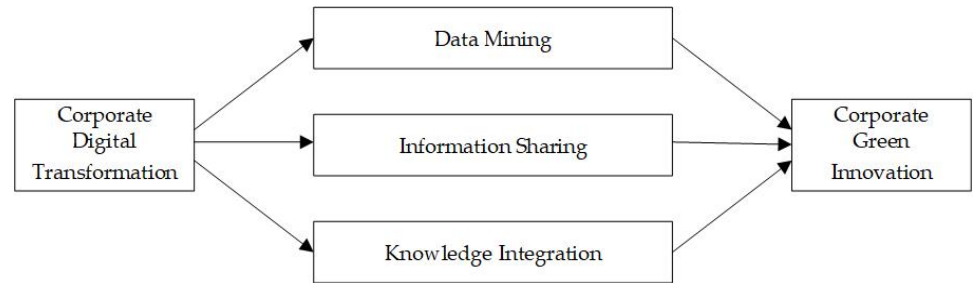
Figure 1. Logic chain of corporate digital transformation affecting green innovation. Hypothesis 1. Corporate digitalization has a positive impact on green innovation